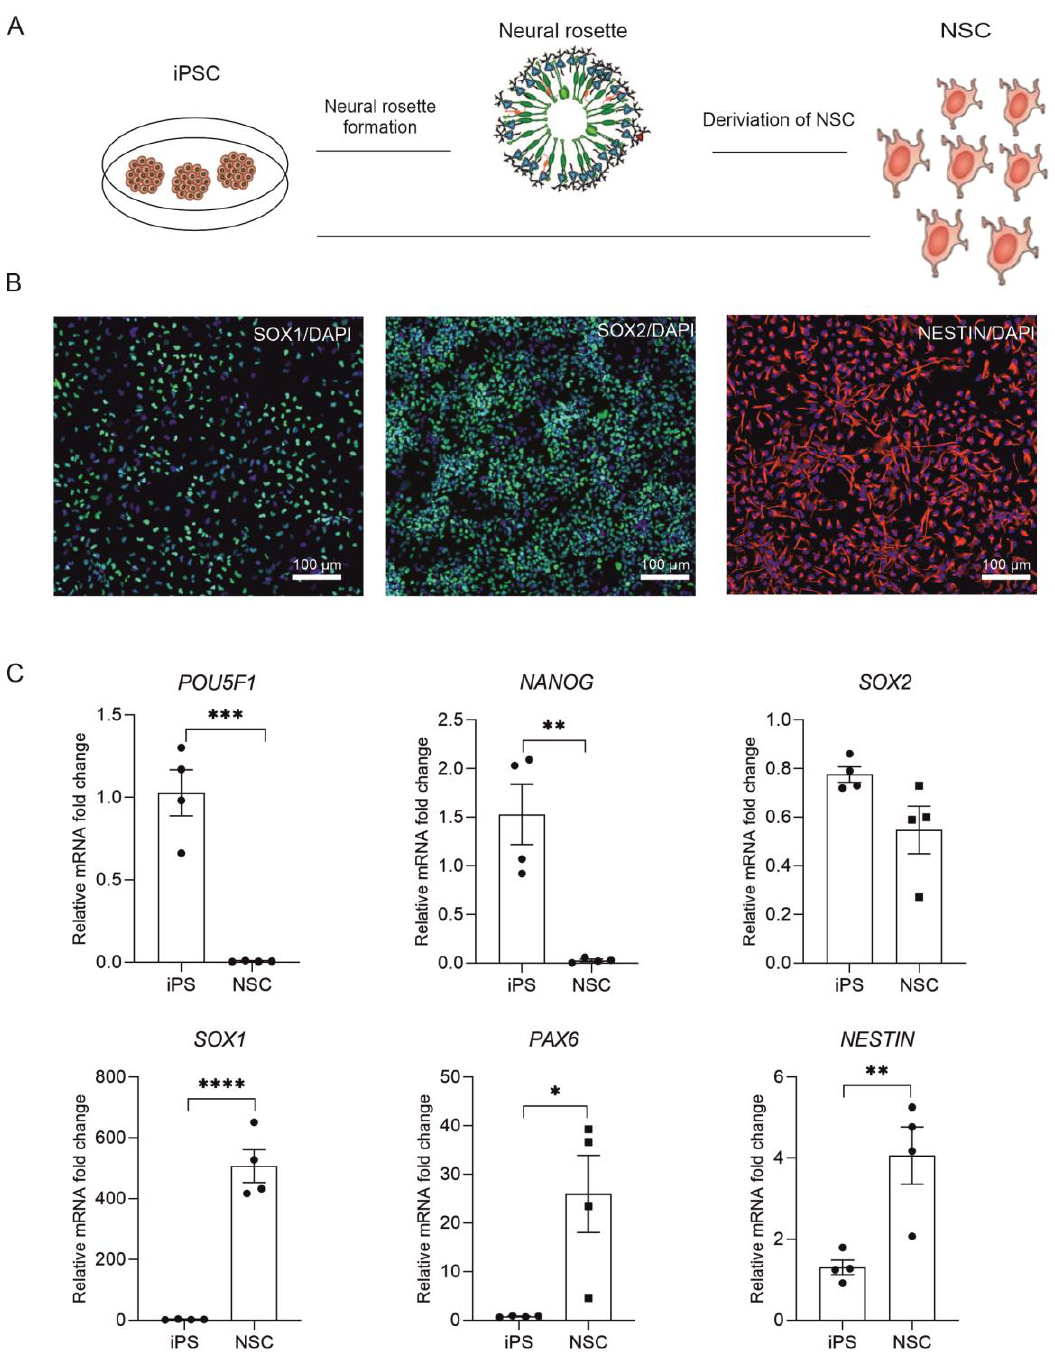
Figure 1. Human induced pluripotent stem cell lines were differentiated into neural stem cells via direct or indirect (neural rosette formation) protocol ( A ). Immunofluorescence staining for NSC markers confirmed successful differentiation ( B ). RT-qPCR analysis confirmed decreased expression of pluripotency markers ( POU5F1, NANOG , SOX2 ) and increased NSC markers ( SOX1 , PAX6 , NESTIN ) in differentiated cells. Graphs represents mean ± SEM. Each dot represents an individual cell line (mean from 3 experiments conducted on 1 cell line) ( C ). Statistical analysis was conducted using t-student test (* p < 0.05, ** p < 0.01, *** p < 0.001, **** p < 0.0001). During 7 days of culturing iPSC in differentiation, we observed specific changes in cell morphology. Between days 5 to 7 we observed the formation of neural rosettes, with a specific